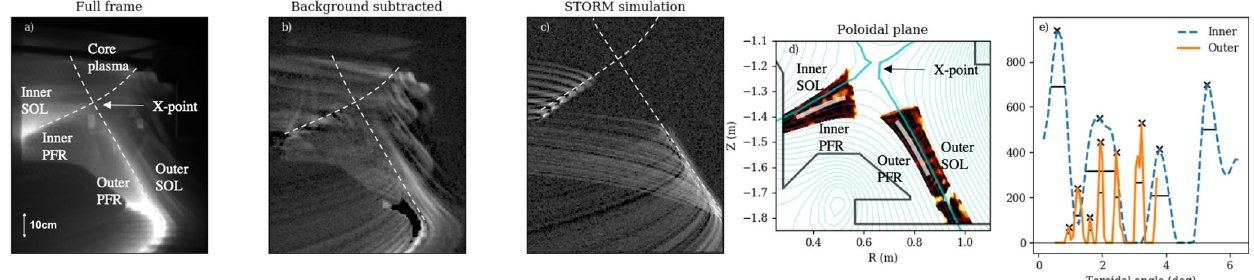
Fig. 8 Example stages of a typical camera data analysis process for divertor turbulence imaging. a , b Raw and background subtracted camera data. c Synthetic camera data from the STORM simulation (see ref. 36 for simulation details). d Tomographically inverted data on sections of the poloidal plane around the inner (closest to the device center) and outer (furthest from device center) divertor legs. White lines indicate line-segments where the emissivity is extracted for analysis in ( e ), the inverted emissivity from the line segments in ( d ) projected onto the toroidal angle on the ψ N = 0.99 fl ux surface where ψ N is the normalised poloidal fl ux coordinate. Crosses mark detected peak locations, horizontal lines show local Full-Width Half-Maxima.